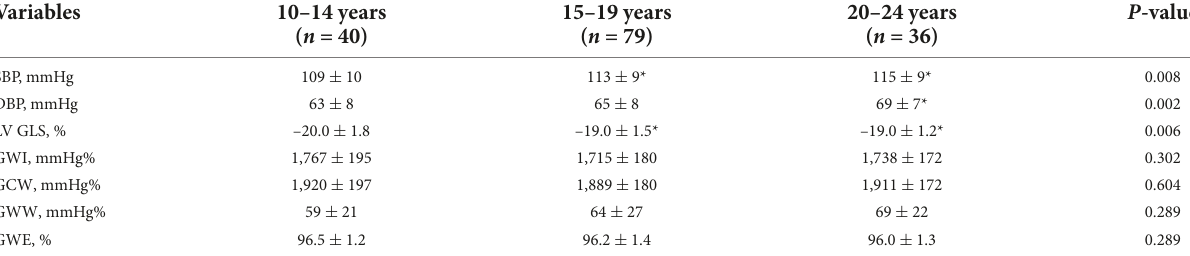
TABLE 2 Brachial blood pressure and advanced echocardiographic parameters by age groups. Variables